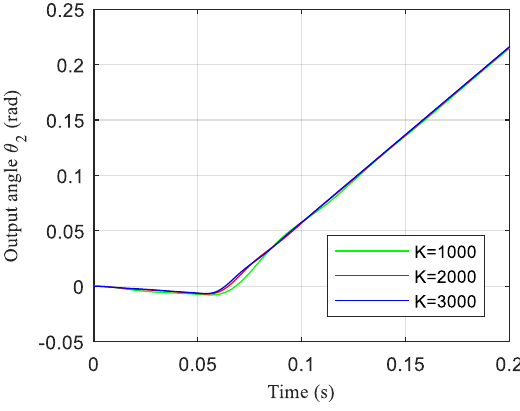
Figure 14. The response curve of the joint output angle.